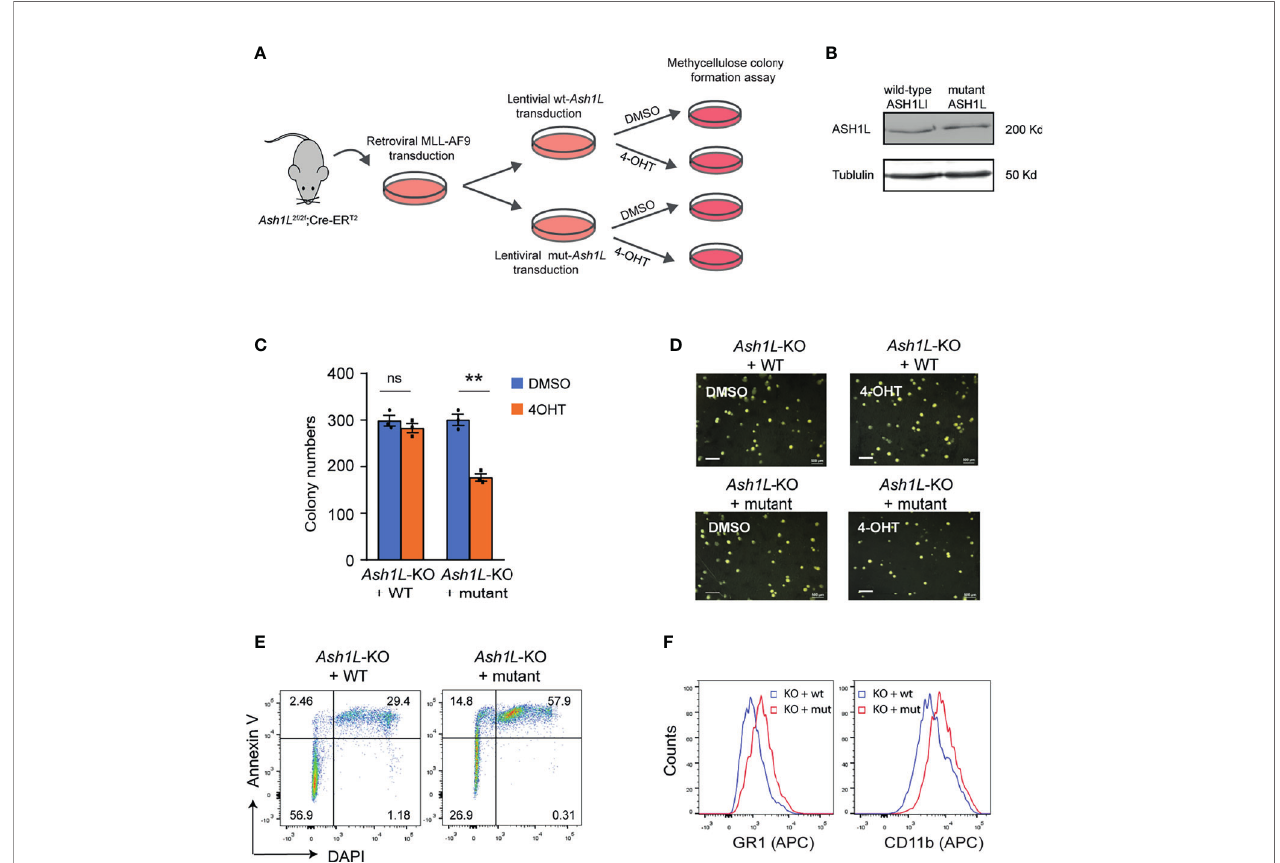
FIGURE 4 | The enzymatic activity of ASH1L is required for its function in promoting MLL-AF9-induced leukemic transformation. (A) Schematic experimental procedure. (B) WB analysis showing the ectopic expression of wild-type and mutant ASH1L. (C) Methylcellulose colony formation assays showing the colony numbers. The error bars represent mean ± SEM, n = 3 per group. ** P < 0.01; ns, not signi fi cant. (D) Photos showing the representative colony formation on methylcellulose plates for each group. Bar = 0.5 mm. (E) Representative FACS results showing the Annexin V+ and DAPI+ populations of Ash1L -KO cells rescued with wild-type and mutant ASH1L. (F) Representative FACS results showing the GR1 and CD11b expression of Ash1L -KO cells rescued with wild-type and mutant